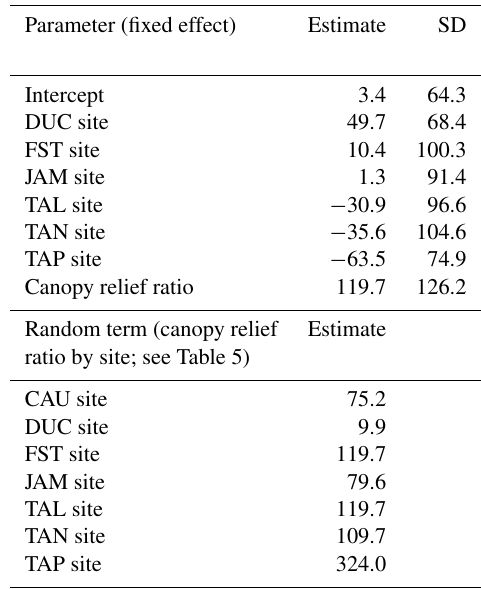
Table B1. Fixed and random effects parameters of the historical scenario model for intact